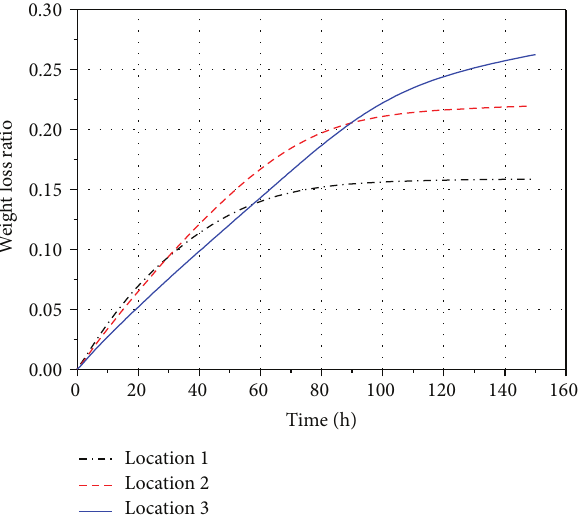
Figure 9: The weight loss ratio of locations 1, 2, and